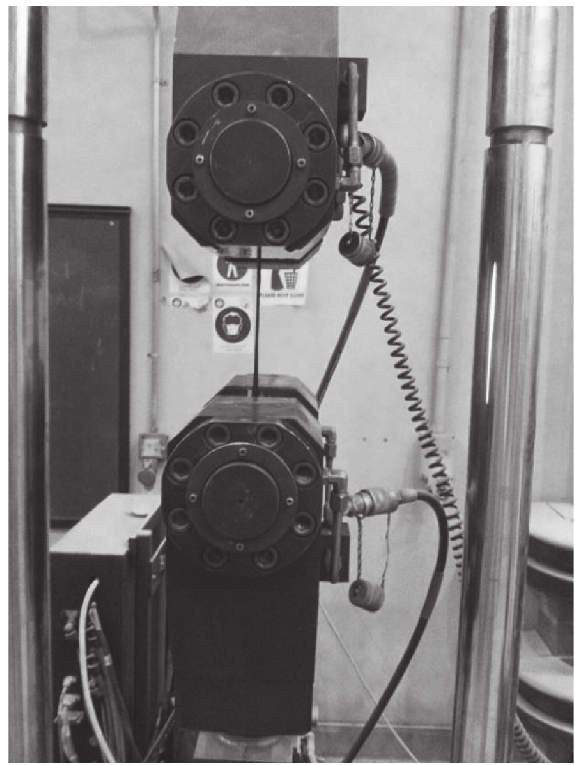
Figure 2: The tensile test setup and elongation of textile fibres.